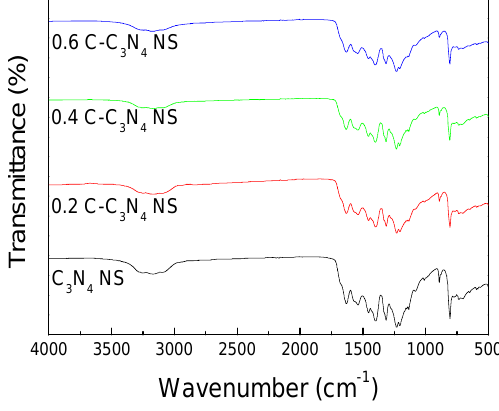
Figure 2. FTIR spectra of C 3 N 4 NS and C ‐ C 3 N 4 NS samples.